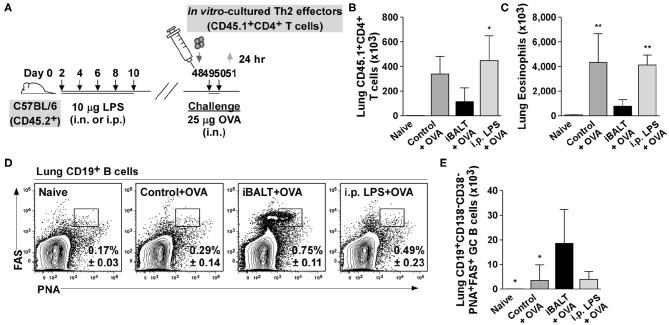
Pulmonary, but not systemic LPS administration leads to iBALT formation and reduced inflammatory responses in the lung. (A) Timing of iBALT induction, transfer of effector Th2 cells and antigen challenge. The numbers of donor T cells (B) and eosinophils (C) in the lungs was demined by flow cytometry 24 h after the last OVA challenge. The frequency (D) and number (E) of GC B cells in the lungs was determined 24 h after the last OVA challenge by flow cytometry. All data show mean ± SD of 4–5 mice per group; *P < 0.05, **P < 0.01. Experiments were performed 3 times (A–E).